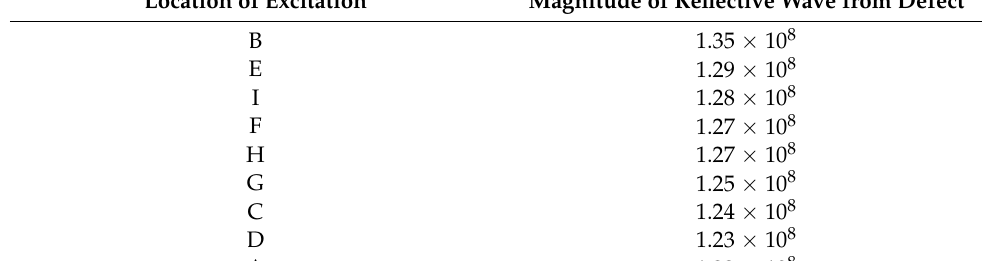
Figure 9. Time responses of panel with and without defect at 20 kHz excitation.